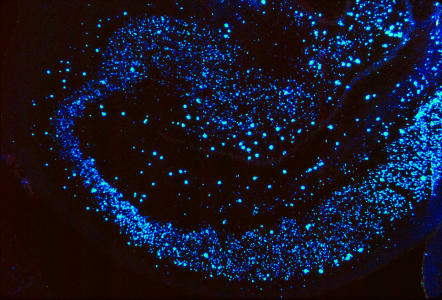
A Constellation of NeuronsImage courtesy of Miles Herkenham.